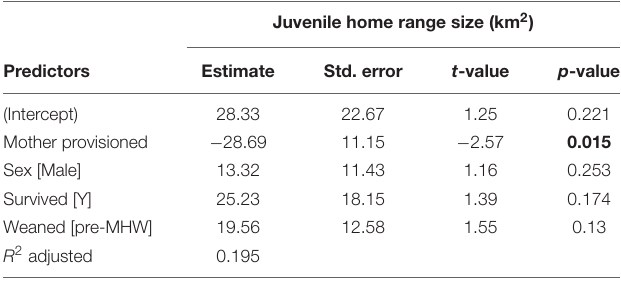
TABLE 2 | Juvenile home range size is significantly correlated with maternal provisioning status, indicated in